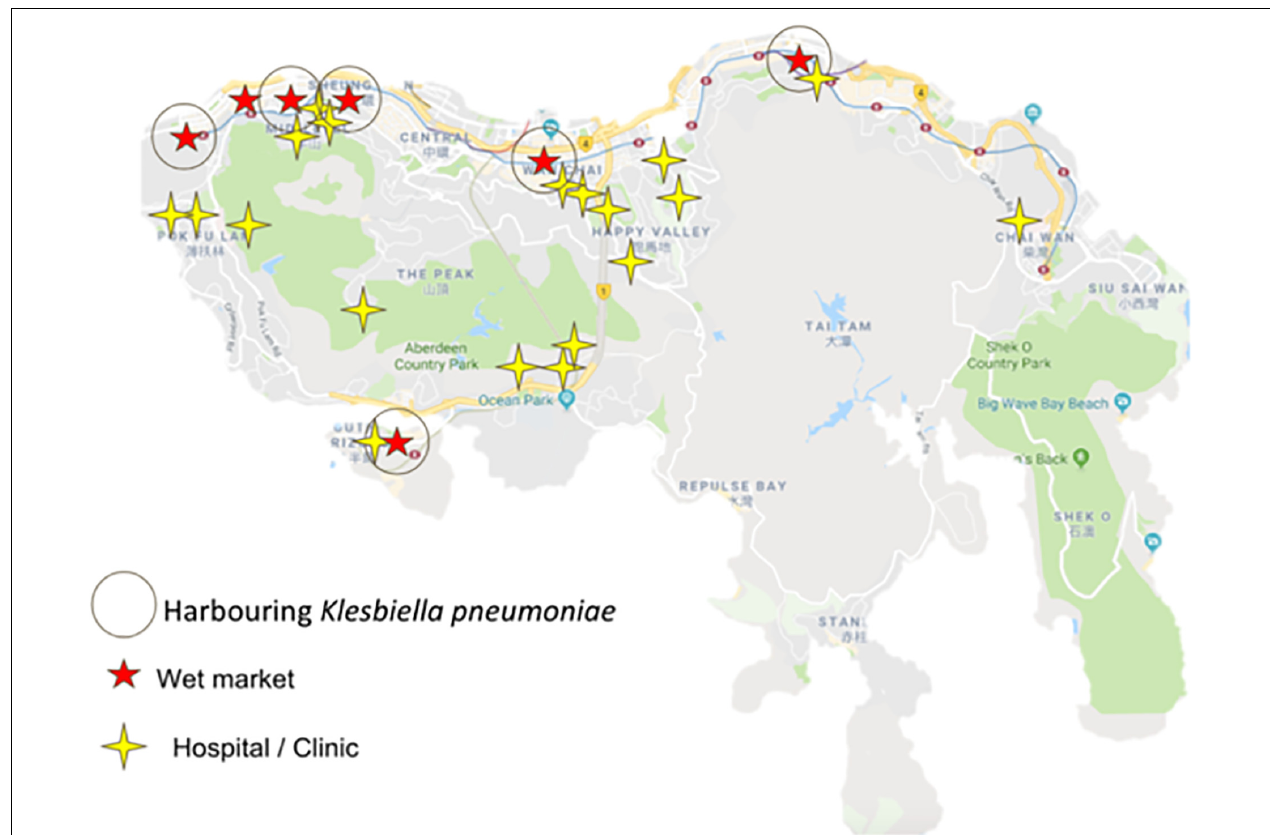
FIGURE 3 | Marked locations of sampled wet markets harboring Klebsiella pneumonia and hospitals in Hong Kong